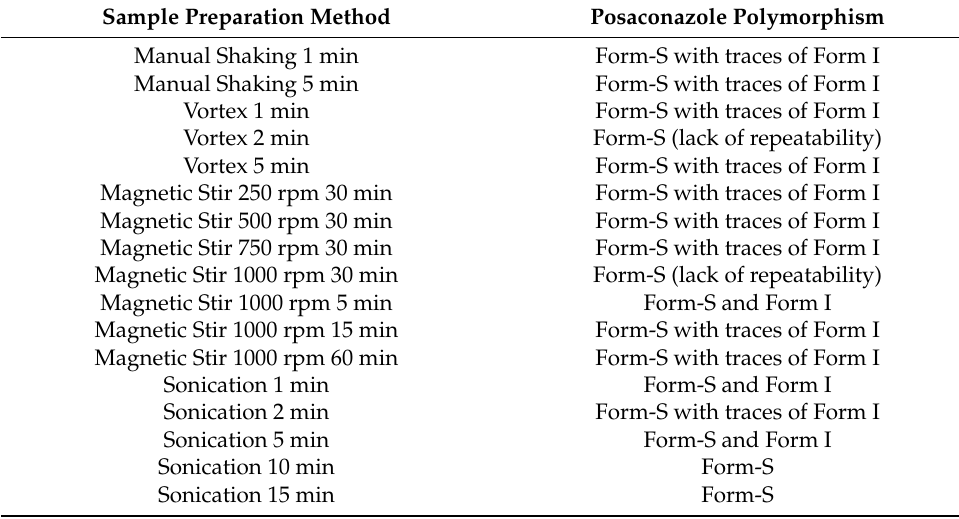
Table 2. The results of the polymorphic conversion of posaconazole Form I to Form-S in 40 mg/mL aqueous dispersions prepared by different sample preparation methods.